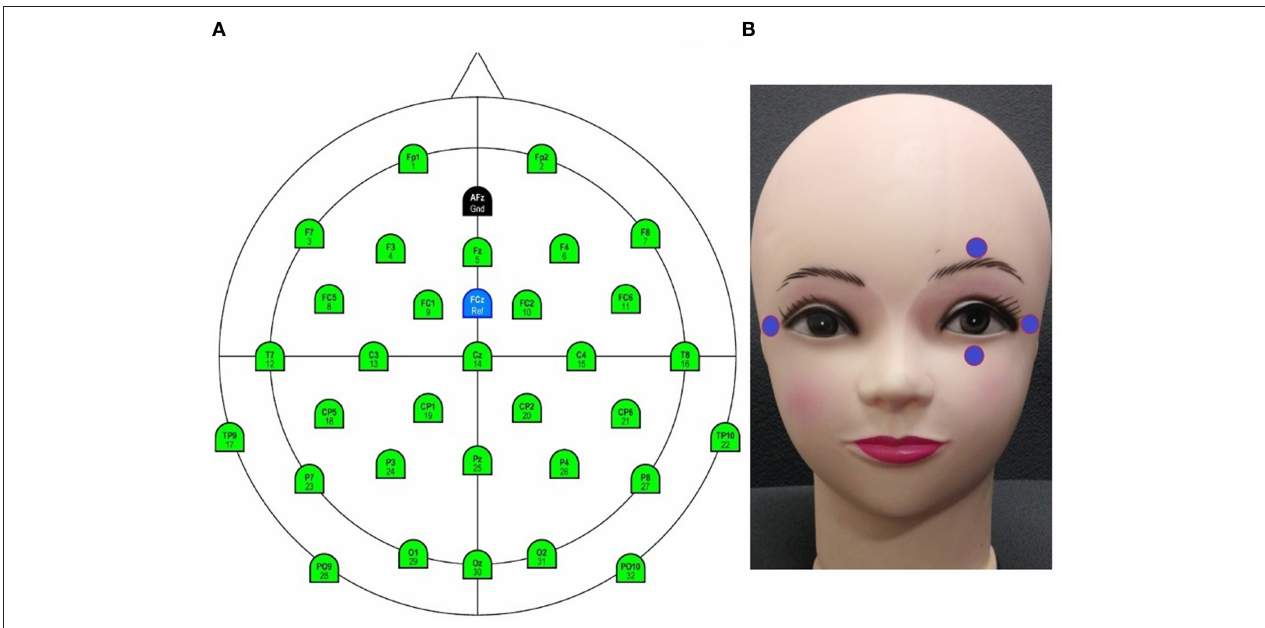
FIGURE 3 | Electrode configurations (A) Electroencephalogram (EEG). (B) Electrooculogram